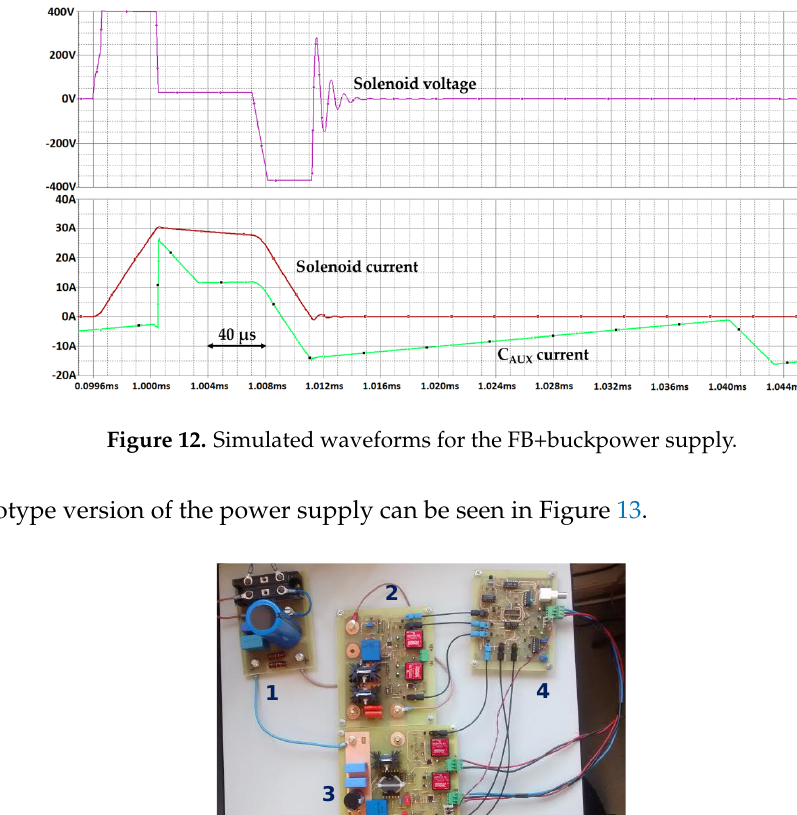
Figure 13. Experimental version of the power source. 1—Input rectifier. 2—Power bridge. 3—Auxiliar buck converter. 4—Control stage.